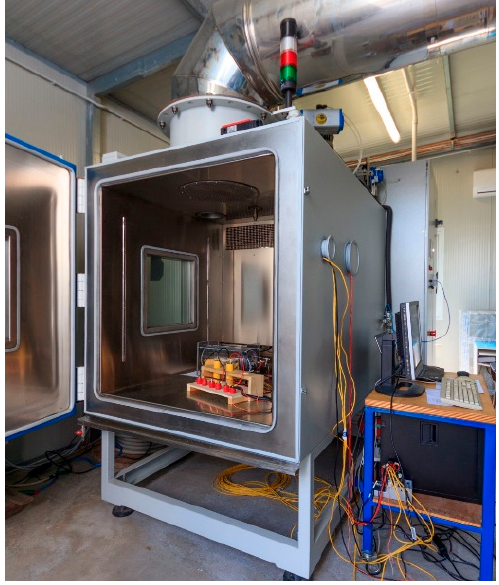
Figure 1. Climatic chamber for abuse test.